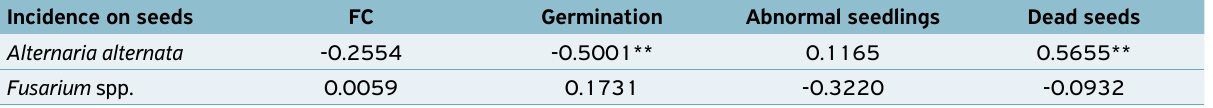
Table 3. Coefficients of linear correlation (r) between the incidences of fungi observed and physiological quality of 34 samples of tobacco